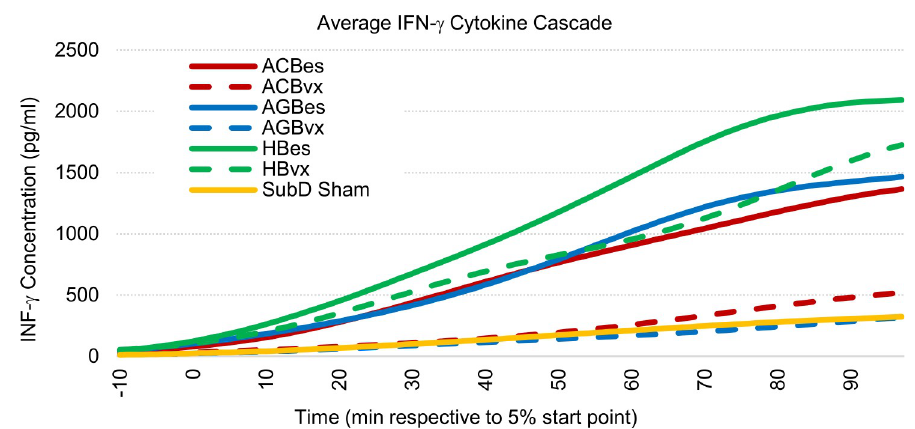
Fig 10. Averaged IFN- γ cascade responses to IP injection of LPS (5 mg/kg). All samples were curve fitted and aligned at the time they reached 5% of peak concentration, represented as time “zero.” Time axis extends to the last time point at which all samples were still